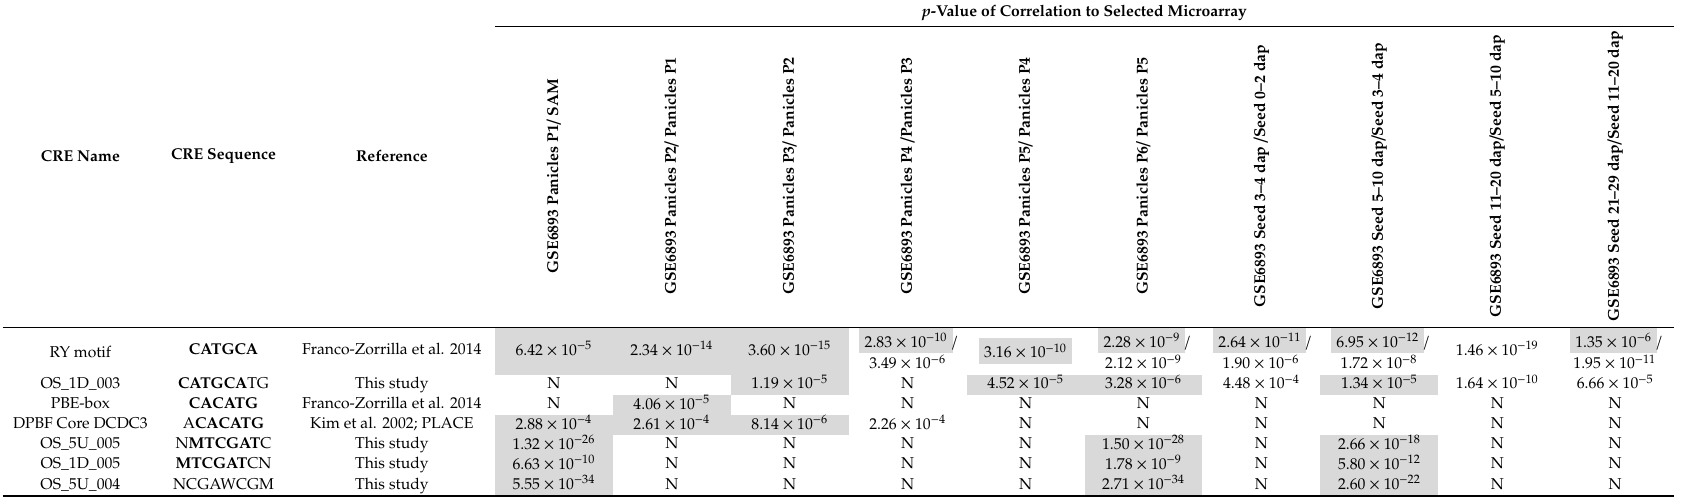
Table 4. CREs that can be correlated to experiments related to floral and grain development